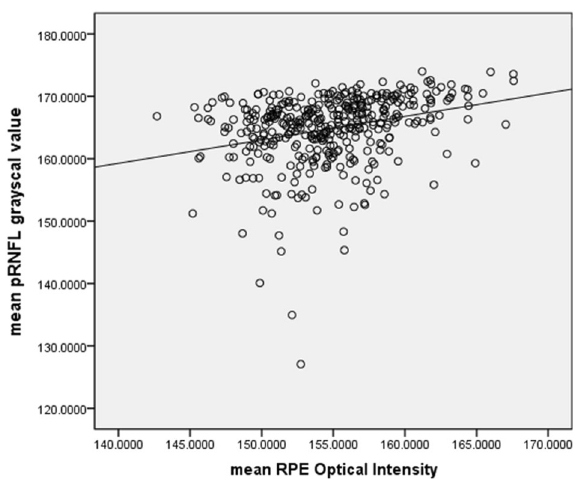
Figure 5. Scatterplot of mean pRNFL grayscale value against RPE grayscale